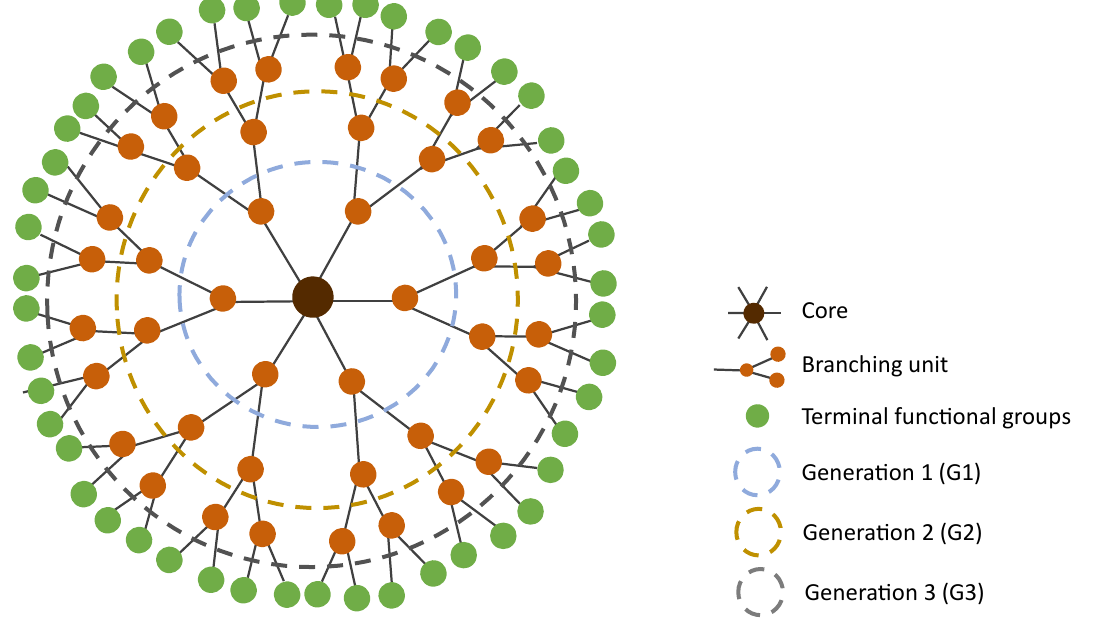
Figure 2. Two-dimensional representation of a spherical structure of generation 3 (G3) dendrimer.